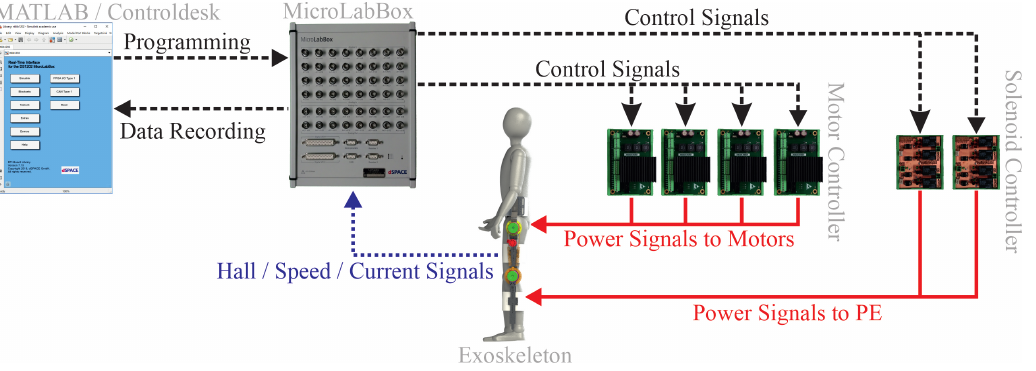
Figure 5. Schematic diagram of the experimental setup using the four actuators. Four parallel connected SDR-480P-48 power supplies (MEAN WELL Enterprises, New Taipei, Taiwan) are used to supply the actuators. This configuration provides a nominal voltage and current of 48 V and 36 A, respectively. Regarding the safety of the test subject during the experiments, the power supply units are connected to the power grid via a PSR relay module (Phoenix Contact GmbH & Co. KG, Blomberg, Germany) so that there are two emergency stop buttons to disconnect the power supply. In addition to disconnection from the mains, operating the switch also disables all motor control units. Since it is not possible to recycle the power grid voltage by the DC power supply units used, two DSR 70/30 brake choppers (Maxon Motor AG, Sachseln, Switzerland) were utilized to protect the power supply units. This effectively prevents an overvoltage at the power supply units, only leading to a deactivation of the power supply in the worst